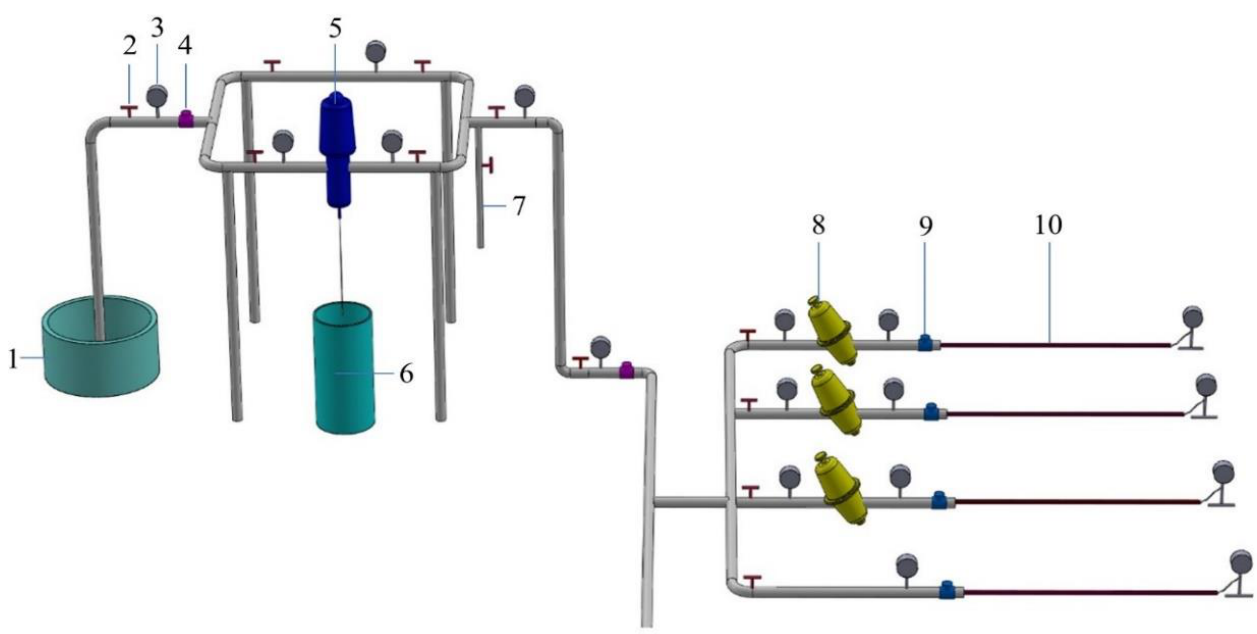
Figure 1. Single plot experiment layout. 1 Water inlet; 2 Valve; 3 Pressure gauge; 4 Water meter; 5 Proportional fertilizer pump; 6 Fertilizer solution bucket; 7 Water intake; 8 Filter; 9 Ultrasonic flowmeter; 10 Driplines.